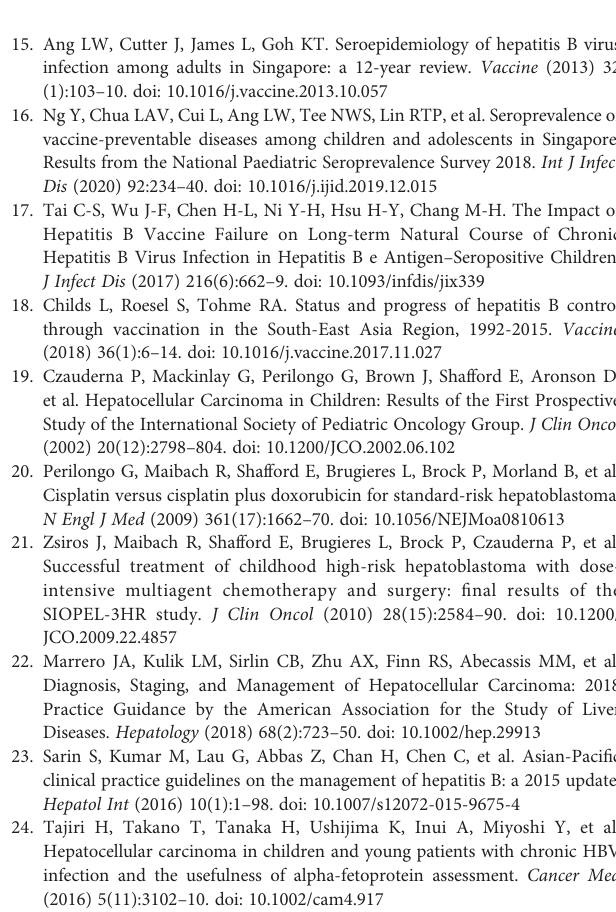
SUPPLEMENTARY TABLE 2 | Demographics, biochemical, radiographical characteristics according to study